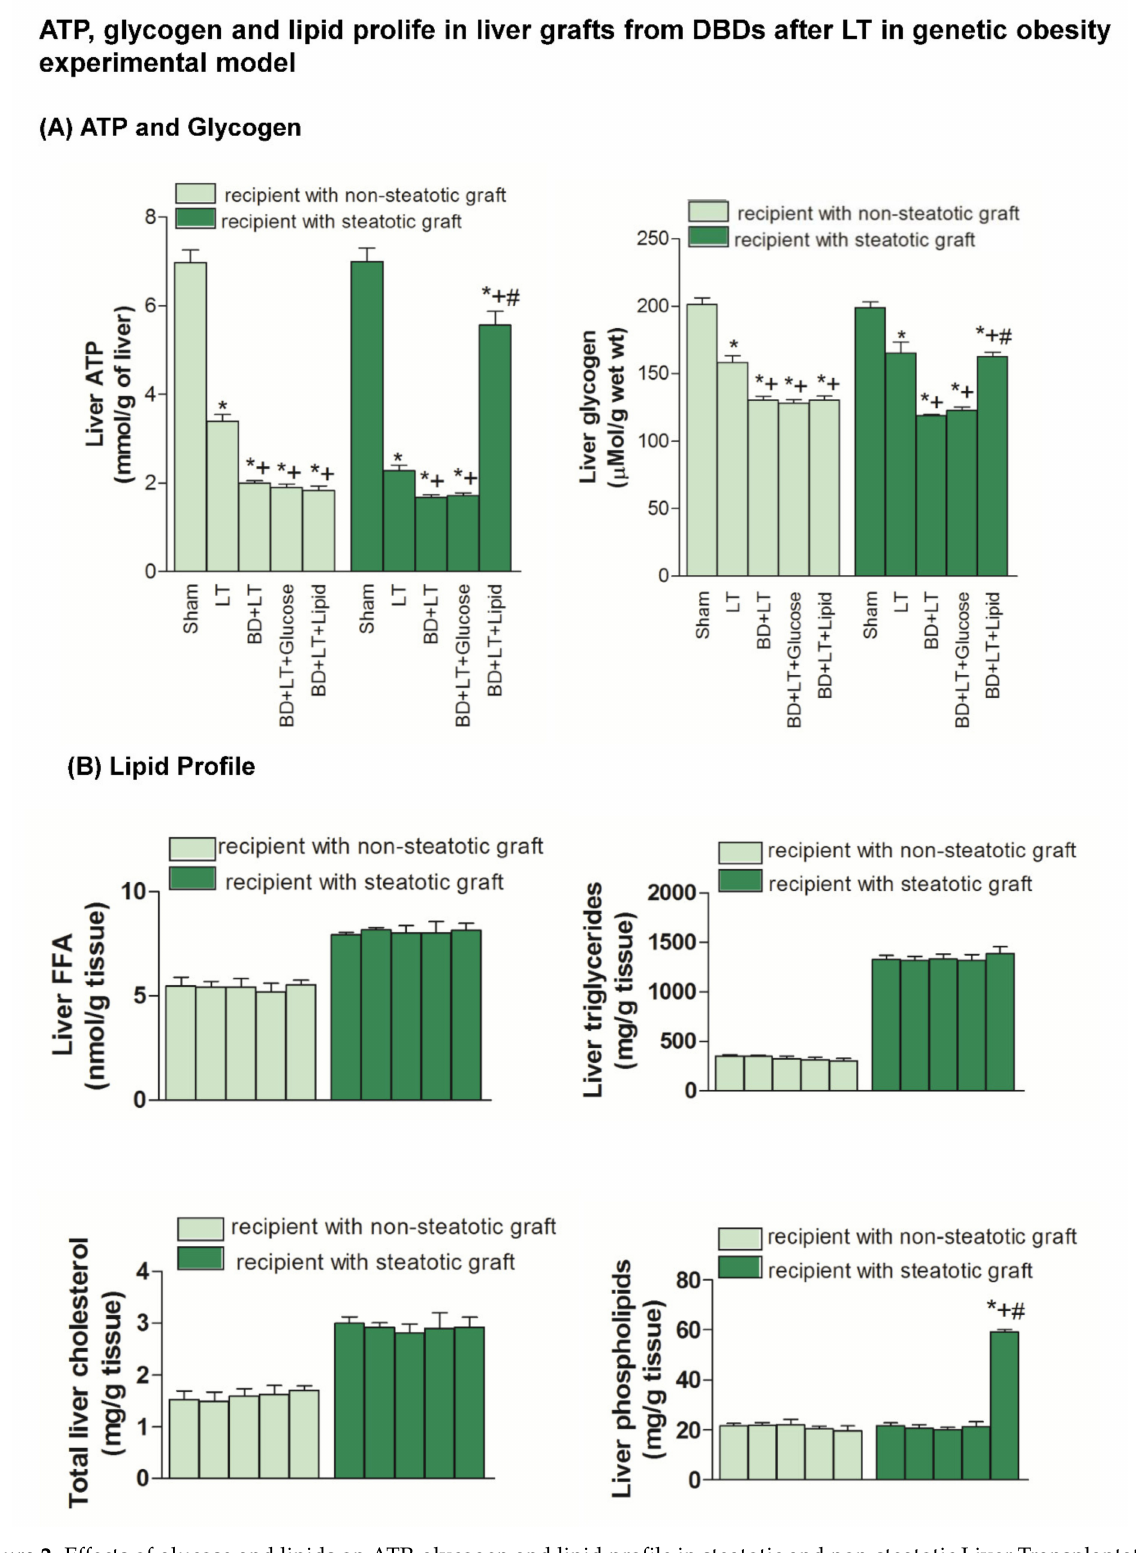
Figure 2. Effects of glucose and lipids on ATP, glycogen and lipid profile in steatotic and non-steatotic Liver Transplantation (LT) in a genetic obesity experimental model. ( A ) ATP and glycogen content in liver. ( B ) FFA, triglycerides, total cholesterol and phospholipids in liver. * p < 0.05 vs. Sham. + p < 0.05 vs. Liver Transplantation (LT). # p < 0.05 vs. Brain Death+Liver Transplantation (BD + LT). DBD, Donors after Brain